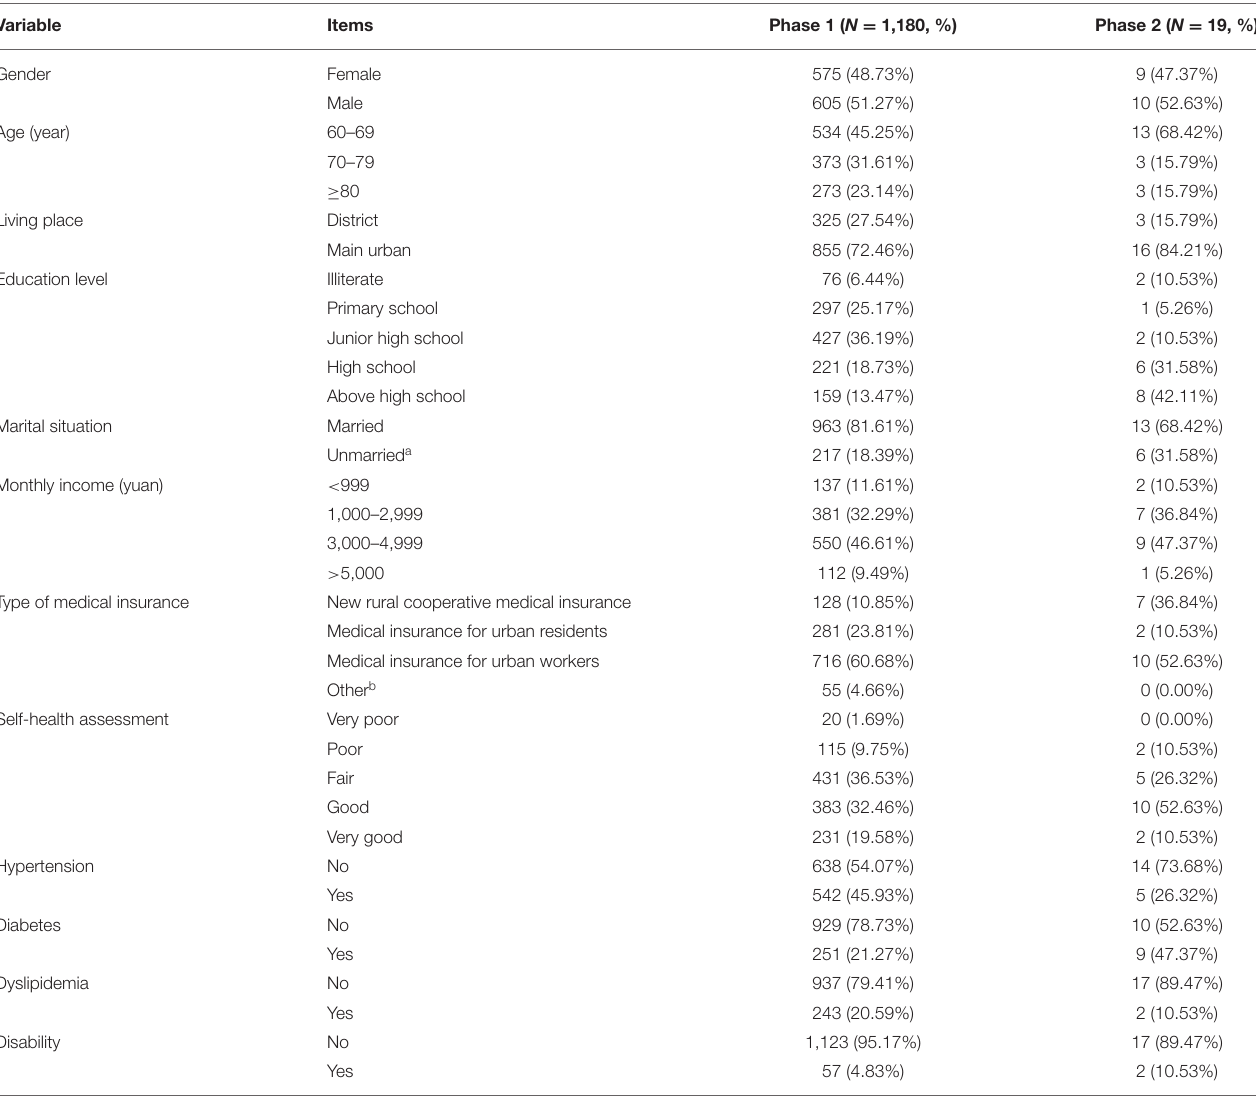
TABLE 2 | Demographic information of all the participants.